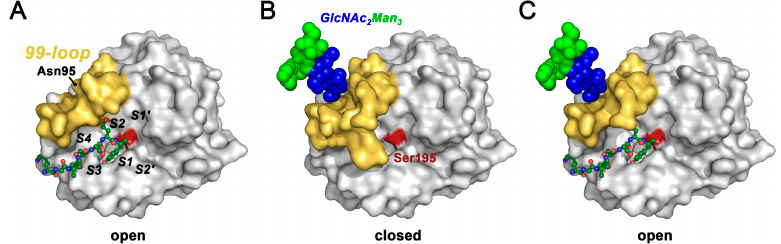
Figure 5. The effect of N -glycosylation at Asn95 on the active site conformation of KLK2 according to crystal structure derived models and kinetic data [140]. ( A ) Glycan-free KLK2 expressed in E. coli exhibits a wide open 99-loop and access of substrates, depicted as green ball-and-stick model bound to the specificity subsites (S4 to S2 ′ specificity subsites are labeled); ( B ) N -glycosylation at Asn95 favors a closed 99-loop, which covers the non-prime side region, left to Ser195 (dark red) in the standard orientation, which prevents substrate binding; ( C ) The N -glycosylated 99-loop of KLK2 opens to a lesser extent than in the glycan-free variant. Thus, substrate binding to glycosylated KLK2 requires more free energy, resulting in a lower k on rate and higher K M .